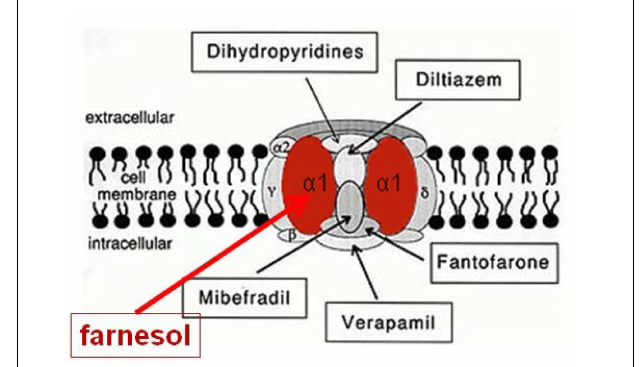
FIGURE 3 | Farnesol is an inhibitor of some types of voltage-gated Ca 2 + channels. Luft et al. (1999) and Roullet et al. (1999) demonstrated for the first time that farnesol binds to the α 1 subunit, which is the pore forming unit of voltage-gated Ca 2 + channels. Ligands for the other subunits are well-documented (Figure modified after Wikipedia, 2018a). Borrowed from De Loof and Schoofs (2019) (Open access).